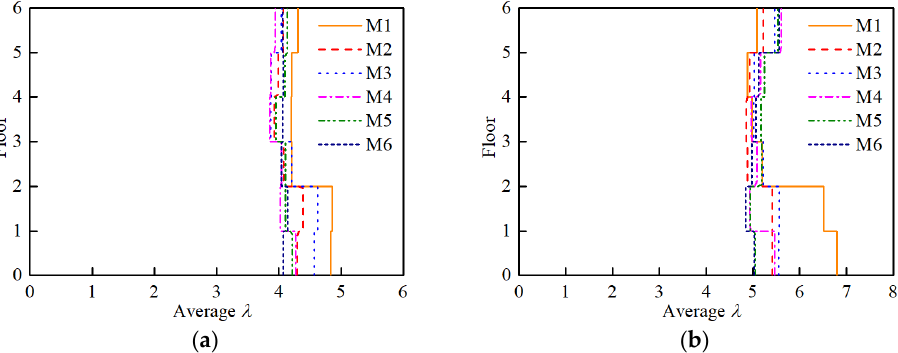
Figure 15. The average 𝜆 of floors across the slope direction: ( a ) a PG, x = 0.4 g; ( b ) a PG, x = 0.62 g. 4.3.3. Column Shear The average 𝜆 of columns at different axes from the 1st floor to the 4th floor at a PG, x of 0.62 g is presented in Table 7. The maximum average 𝜆 of the lower ‐ embedding col ‐ umns is larger than that of the upper ‐ embedding columns. For each model, the maximum average 𝜆 of the upper ‐ embedding columns along the slope direction is less than that across the slope direction. Meanwhile, the maximum average 𝜆 of the upper ‐ embedding columns decreases and then increases from model M1 to model M6. Table 7. The average 𝜆 of columns along and across the slope direction at a PG, x of 0.62 g. Model ID